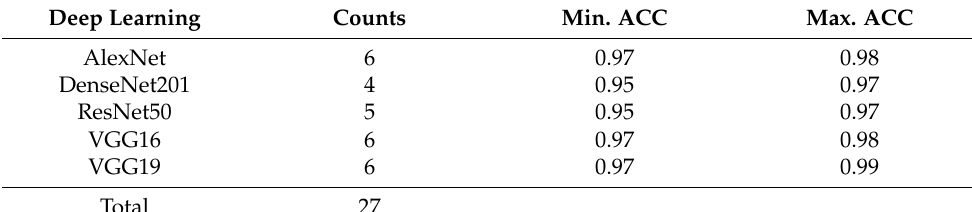
Table 5. Summary of the results in Tables 3 and 4.